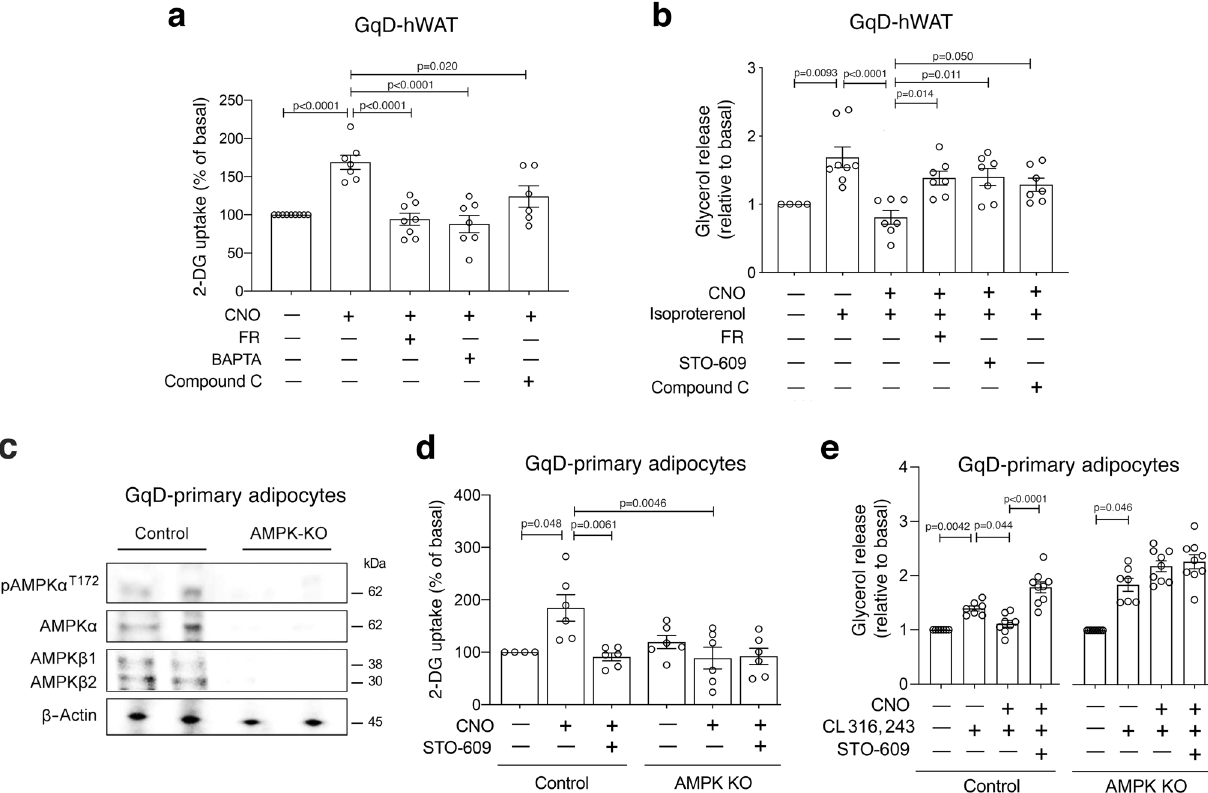
Fig. 5 Studies with human adipocytes and primary mouse adipocytes lacking AMPK. a 2-Deoxy-D-glucose (2-DG) uptake by CNO (10 μ M)-treated GqD- expressing, differentiated human white adipocytes (GqD-hWAT cells) in the presence or absence of FR900359 (FR; 1 μ M), (BAPTA (10 μ M), and Compound C (10 μ M). b Glycerol release after treatment of GqD-hWAT cells with isoproterenol (100nM), CNO (10 μ M), and various pharmacological inhibitors (FR, 1 μ M; STO-609, 2 μ M; Compound C, 10 μ M). c Western blot analysis with GqD-expressing primary mouse adipocytes (source: iWAT) demonstrating the lack of all three subunits of AMPK in AMPK KO cells (control = GqD-expressing primary mouse adipocytes with functional AMPK). This experiment was independently repeated twice with similar results. d 2-DG uptake by CNO (10 μ M)-treated GqD-expressing primary mouse adipocytes in the presence (control) or absence of AMPK (AMPK KO), either with or without STO-609 (2 μ M) co-incubation. e Glycerol release from CNO (10 μ M)-treated GqD-expressing primary mouse adipocytes in the presence (control) or absence of AMPK (AMPK KO). Lipolysis was induced by incubation with CL316,243 (100nM). Experiments were carried out in the absence or presence of STO-609 (2 μ M). Glucose uptake and glycerol release data were normalized relative to values obtained in the absence of any drugs. Data are presented as means ± s.e.m. of at least four independent experiments. a , b , d , e : one-way ANOVA followed by Bonferroni ’ s post-hoc test). Source data are provided as a Source data fi